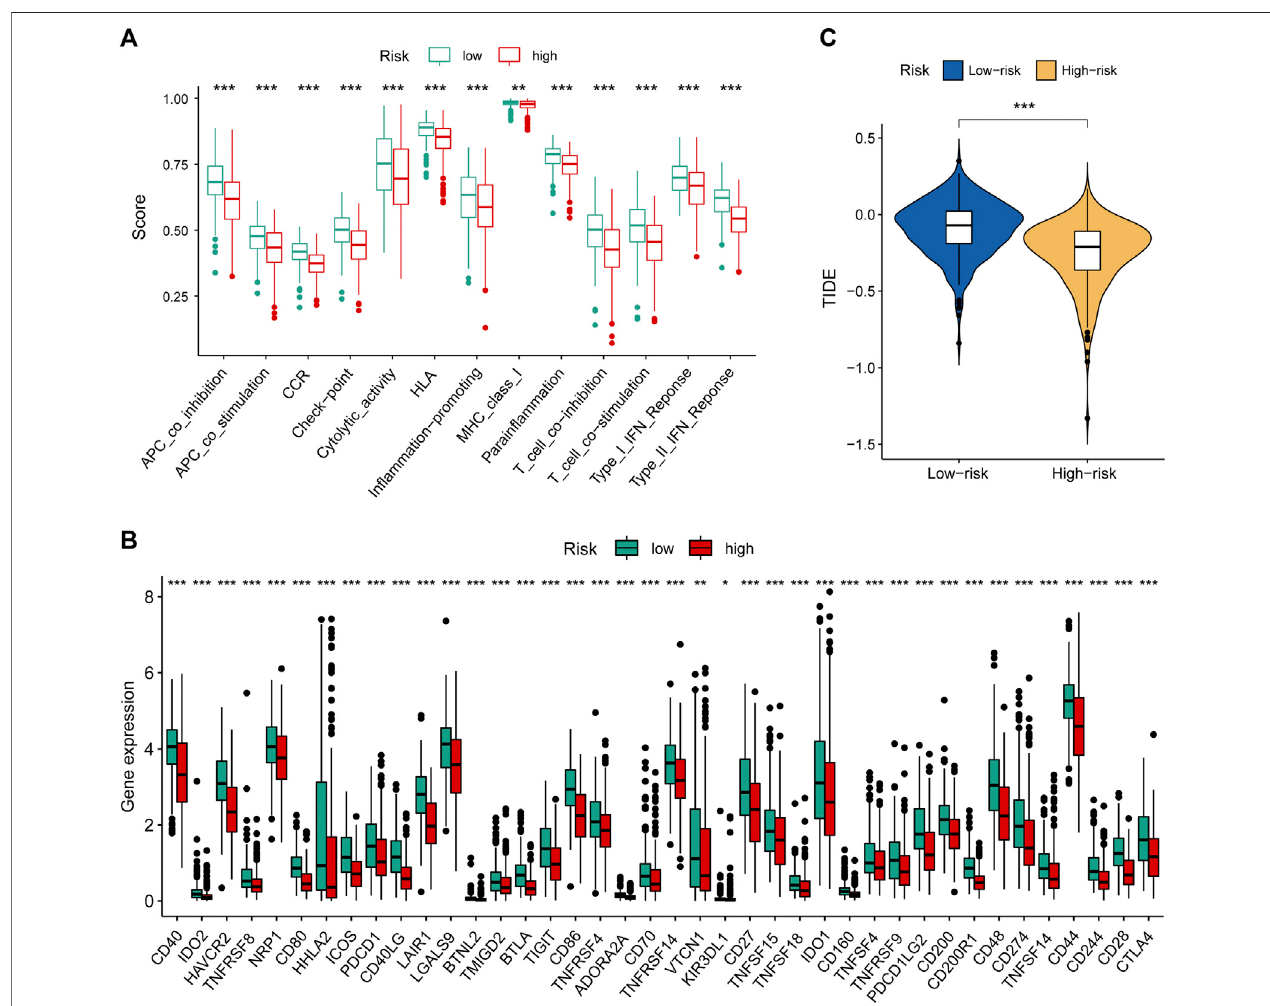
FIGURE 6 | Immune landscape and immunotherapeutic response based on the MHLncSig. (A) The difference of immune function between the low- and high-risk groups. (B) Expression levels of immune checkpoint genes in the low- and high-risk patients. (C) TIDE difference between the low- and high-risk groups.